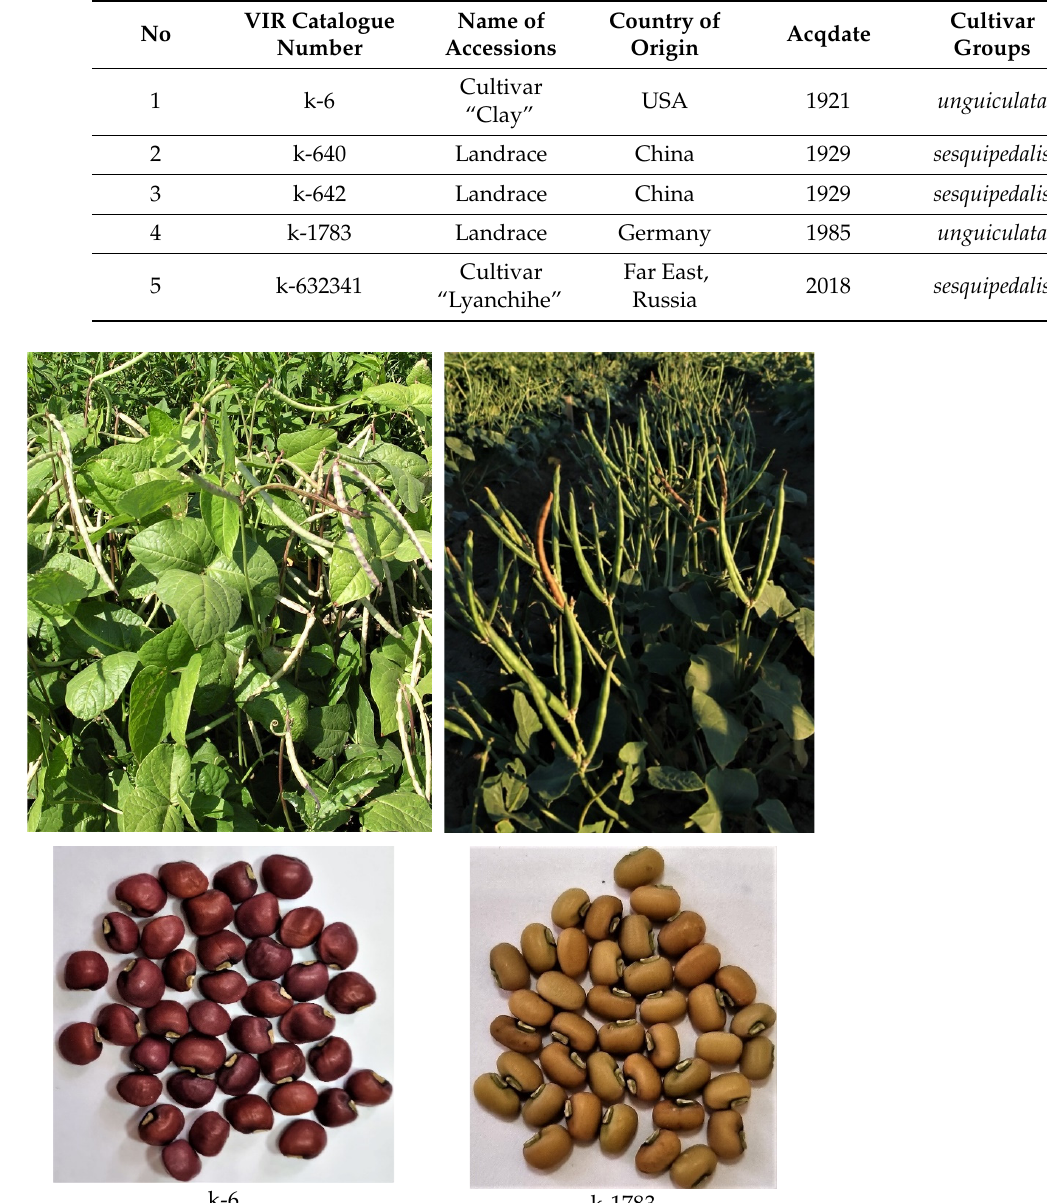
Table 1. V. unguiculata seed material samples.